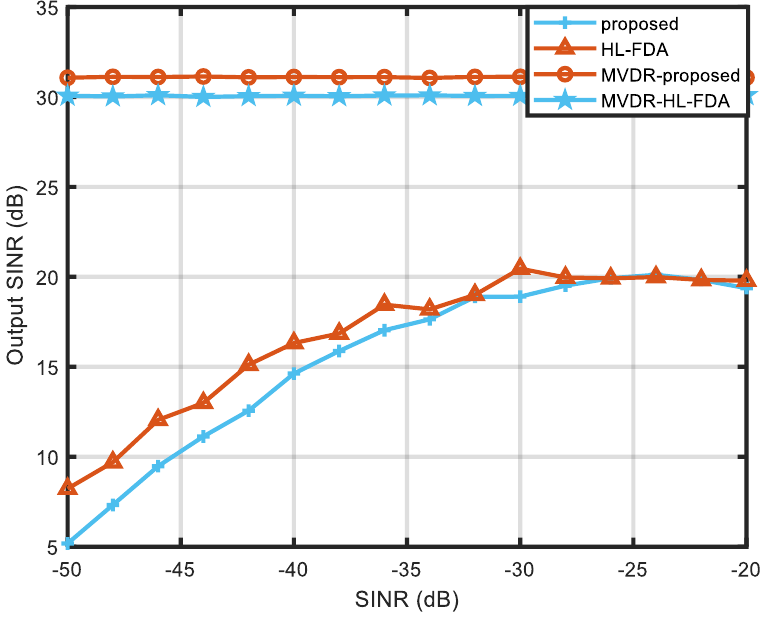
Figure 12. Comparison of output SINR.